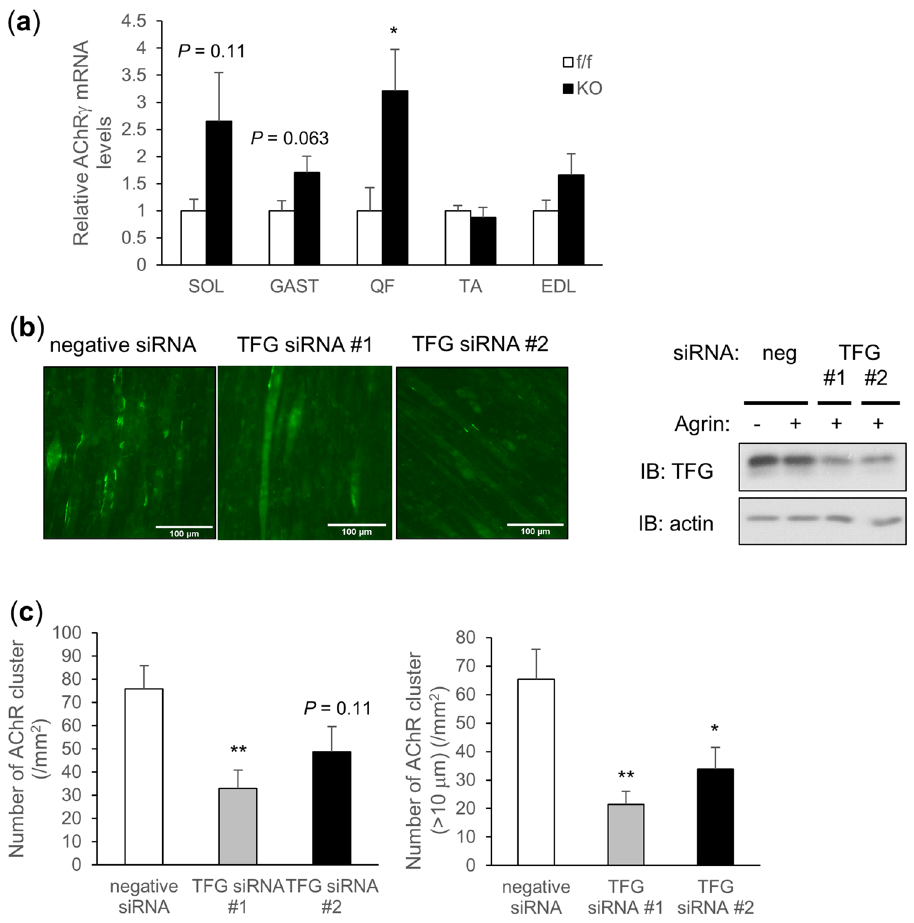
Figure 5. Muscle TFG might be important for neuromuscular junction (NMJ) maintenance. ( a ) Relative AChR γ mRNA levels in each muscle from TFG floxed (f/f) or MUSTFG KO (KO) mice (6- to 7-month-old mice, n = 10–11). ( b ) Agrin-induced AChR clustering in C2C12 myotubes (left panel) (scale bar: 100 µm) and protein abundance of TFG in Western blot (right panel). ( c ) The number of AChR clusters per area (left panel) and the number of AChR clusters larger than 10 µm in diameter (right panel). (* P < 0.05, ** P <